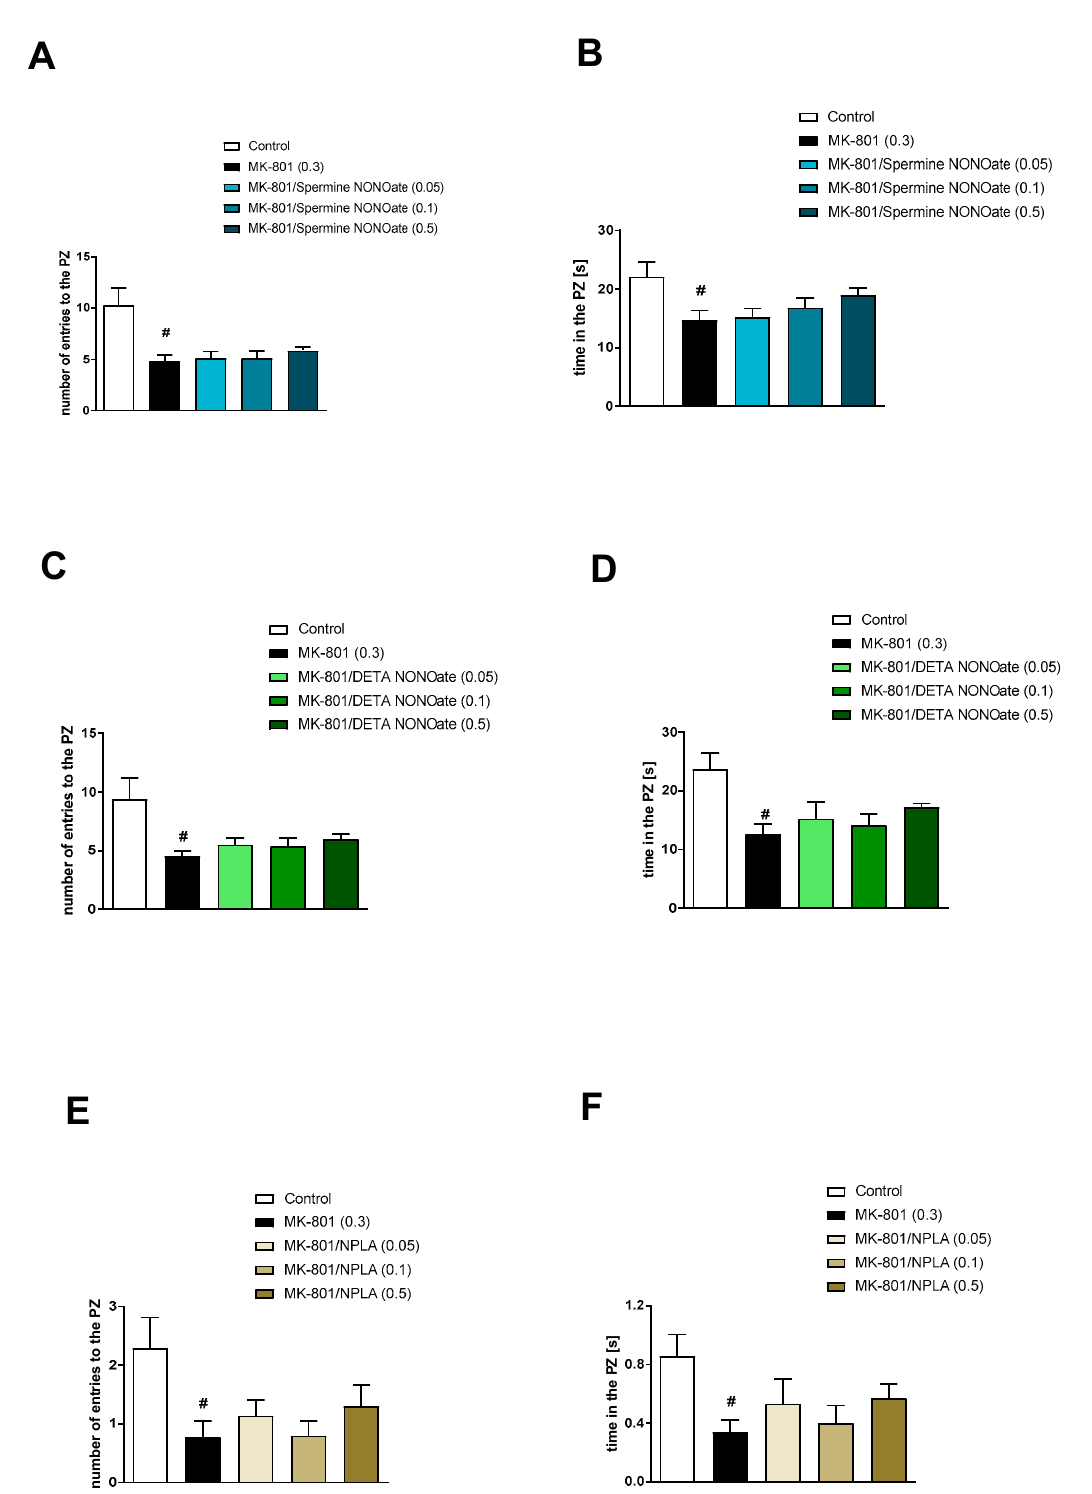
Figure 14. The effects of spermine NONOate ( A , B ), DETA NONOate ( C , D ), and NPLA ( E , F ) on MK-801-induced deficits in the retention of spatial memory in the MWM of CD1 mice. PZ-related parameters. The values are expressed as the means ± SEM. # p < 0.001 vs. control group (N = 8–10). When administered alone, the compounds had no impact on memory retention (Table